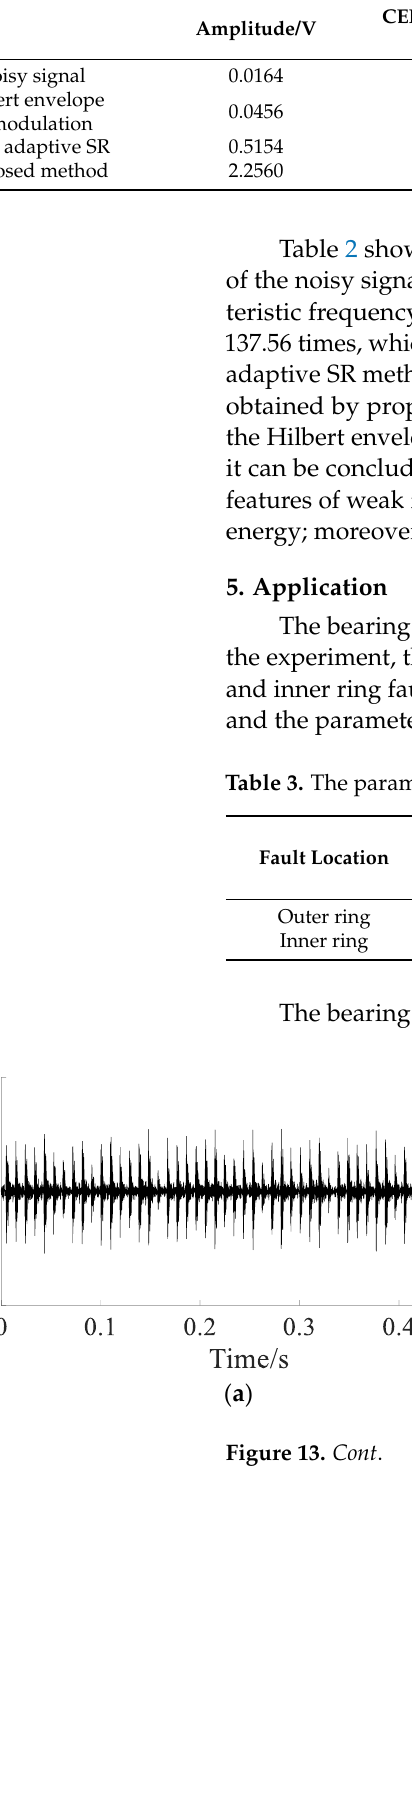
Figure 13. The bearing outer ring fault signals: ( a ) original signal; ( b ) spectrum of the original sig- nal; ( c ) noisy signal; ( d ) spectrum of the noisy signal.